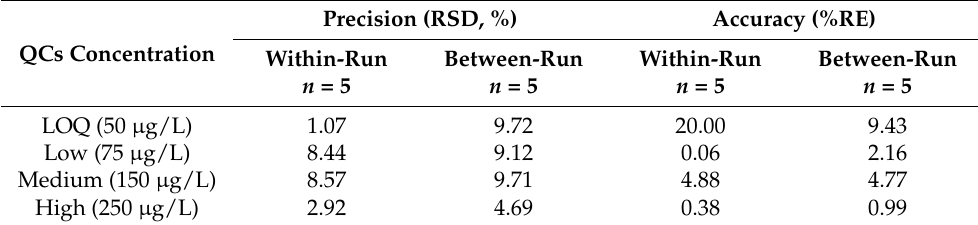
Table 2. Intra-day and inter-day precision and accuracy.